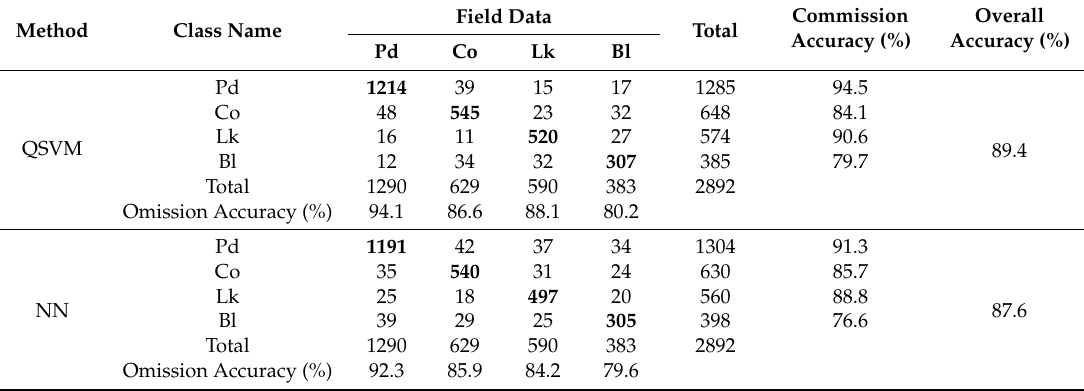
Table 7. Error matrices for the matching tests between detected and surveyed trees. Pd, Pinus densiflora